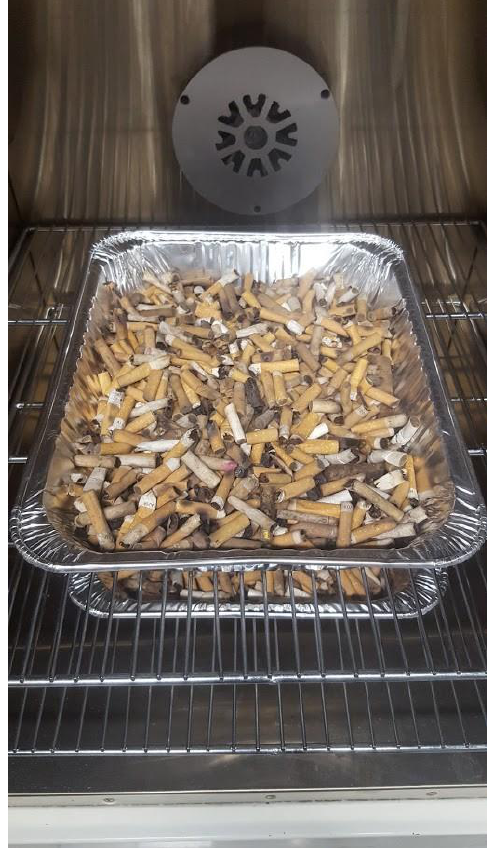
Figure 2. CBs used in this study.